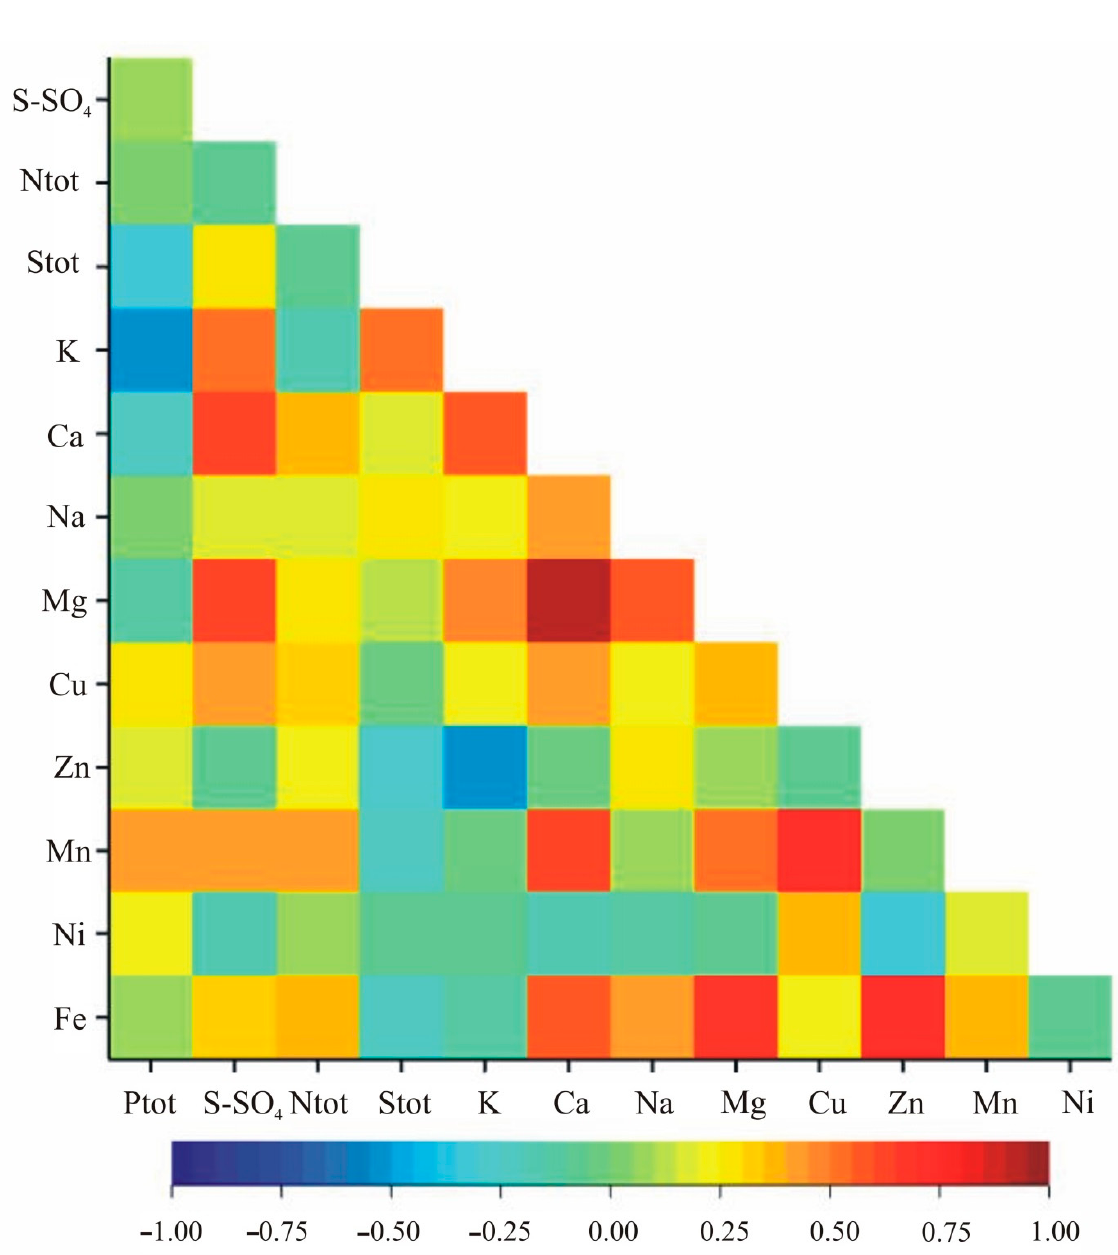
Figure 4. Heatmap for linear Pearson’ correlation coefficients between observed nutrients in the flowering stage ( r cr = 0.36).